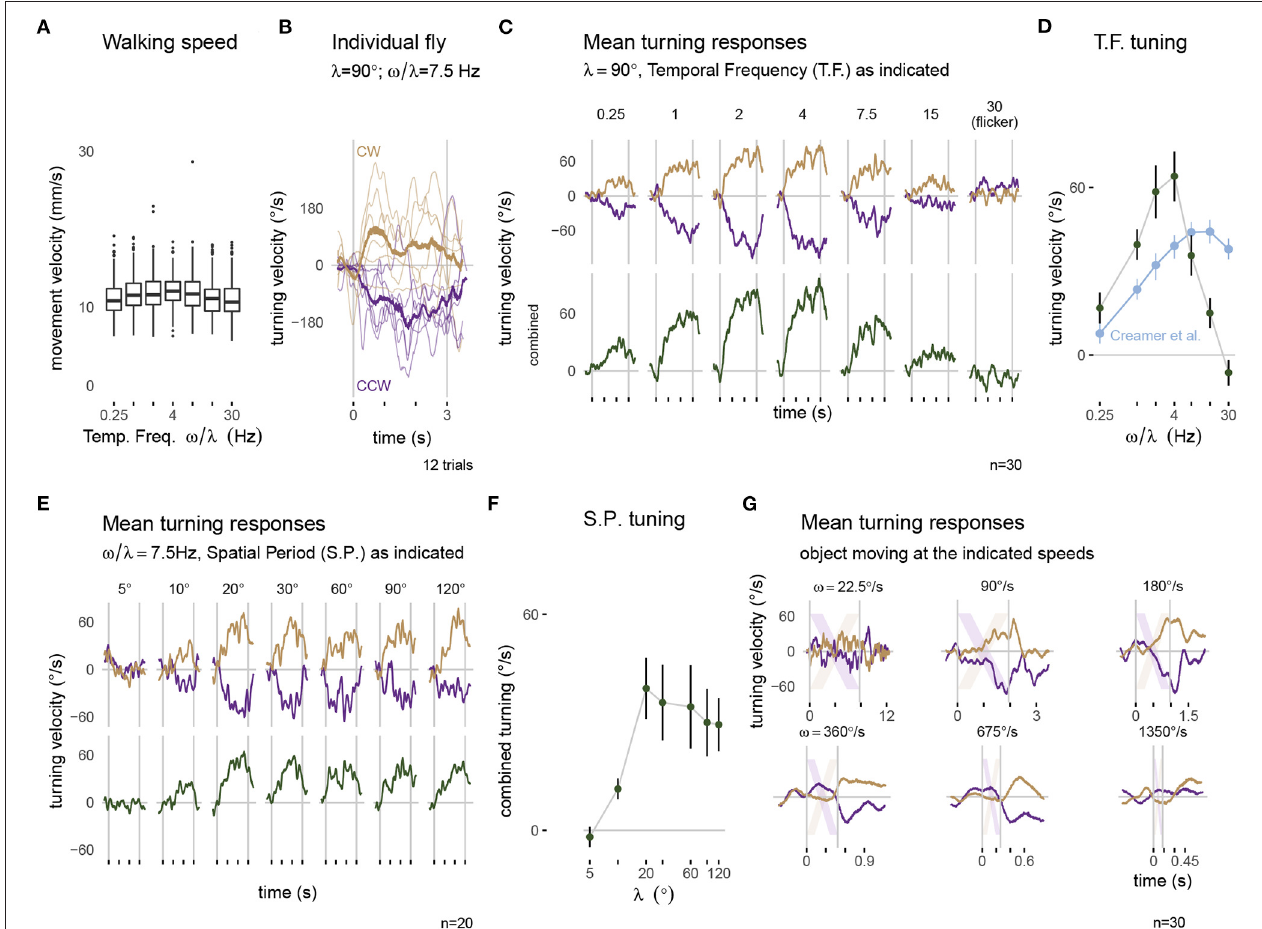
FIGURE 5 | Visually guided turning behaviors measured with the optimized setup. Panels along the top row show walking behavior in response to a moving grating pattern with a spatial period of λ = 90 ◦ . (A) The forward walking speed of flies across the different conditions ( n = 30). (B) The turning response of a single fly to multiple presentations of 3s rotational stimuli moving clockwise (CW, yellow) and counterclockwise (CCW, purple). Thin lines represent single trial responses and the mean response across trials is in the thicker line. (C) The mean turning response across all 30 flies: the top row shows the responses to each direction of motion and the combined responses are plotted below. (D) The tuning curve summarizes the combined response, averaged during the period of stimulus presentation. For comparison, the data in blue is extracted from similar experiments on a different setup, from Figure 1H of Creamer et al. (2018). The mean turning responses for a series of gratings with different spatial periods are plotted in (E) and summarized as a tuning curve in (F) . (G) The mean turning responses to presentations of a single 45 ◦ bar sweeping across the display. The lightly colored stripes represent the expected position of the bar on the display. The box plot in (A) uses first and third quartile to span the box, 1.5 · IQR for the whiskers and outliers are plotted as individual points. The error bar in (D,F) are plotted as mean ± SEM. A consistent color code for clockwise responses (yellow) and counterclockwise responses (purple) is used in panels (B,C,E,G)